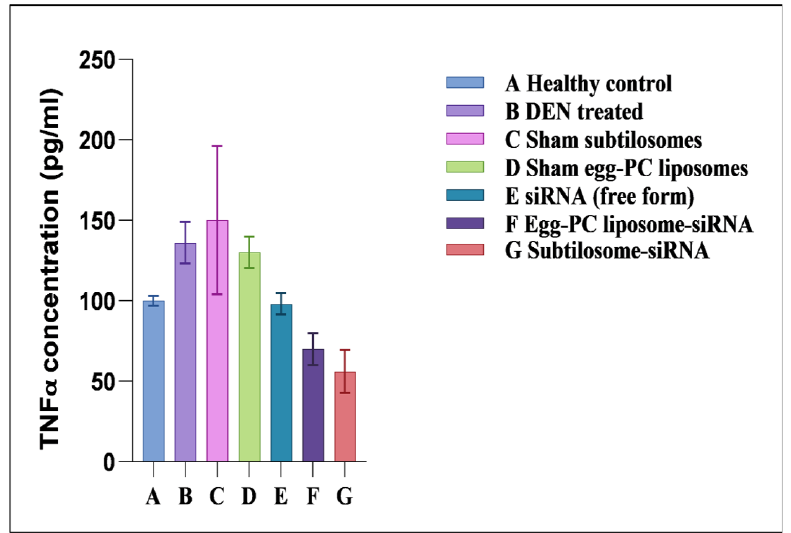
Figure 6. TNF- α -expression profiles of animals treated with different siRNA formulations. TNF- α levels were measured in plasma, as described in Materials and Methods. Data represented here are the mean of three separate experiments ± SD (siRNA subtilosomes versus free siRNA p < 0.05, siRNA-PC liposomes versus free siRNA p < 0.05, siRNA subtilosomes versus siRNA-PC liposomes p value not